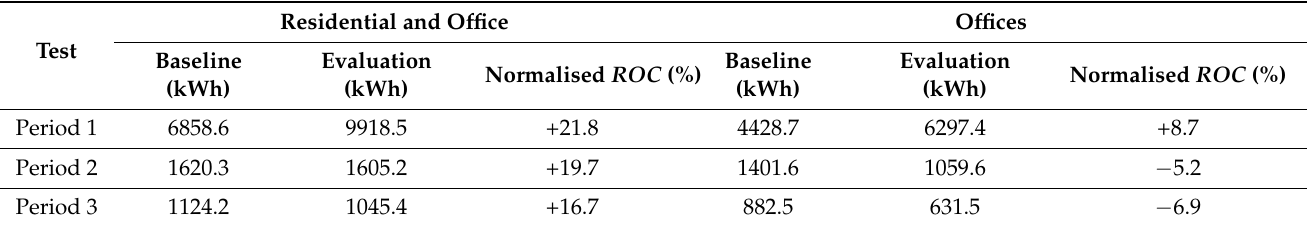
Table 3. Total electric demand before and after the proposed DA.